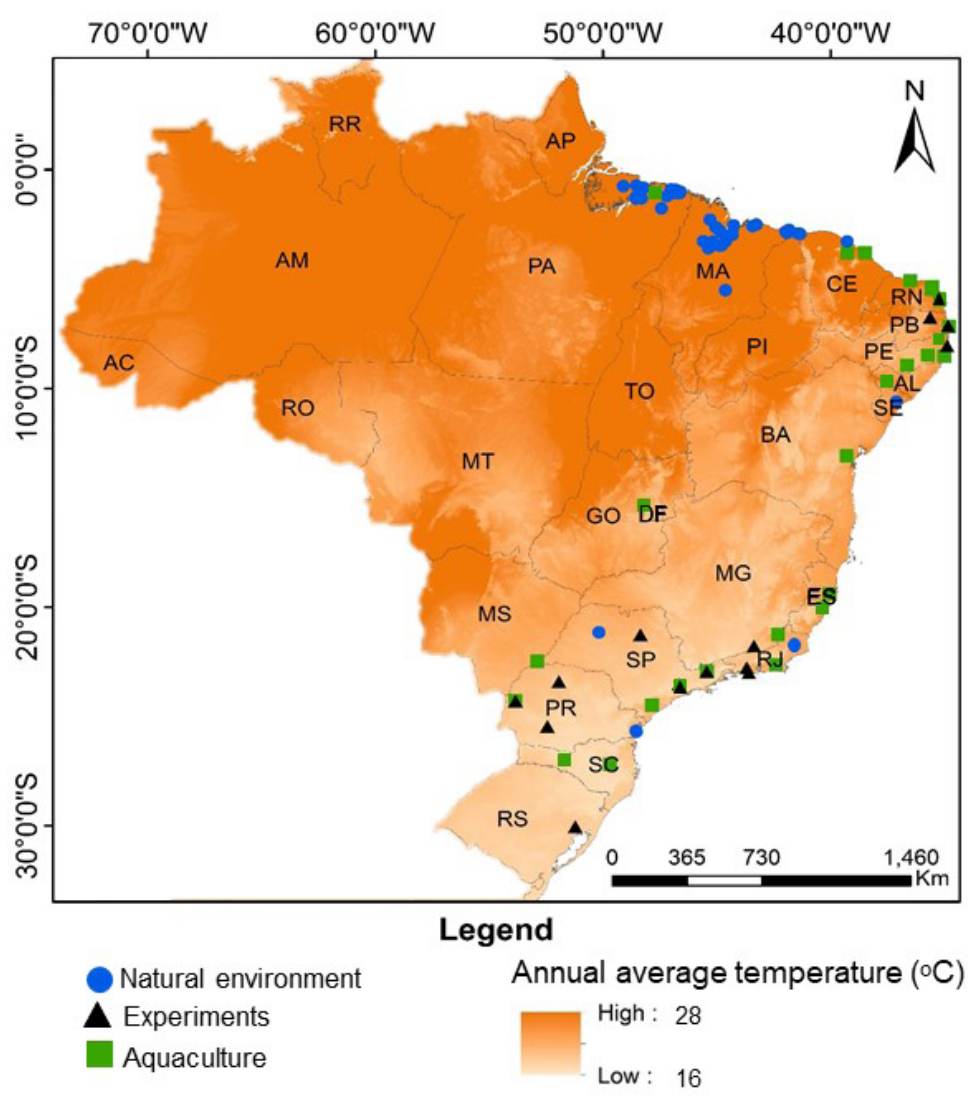
Figure 1. Occurrences of Macrobrachium rosenbergii in Brazil by state and temperature (°C). AC - Acre; AL - Alagoas; AP - Amapá; AM - Amazonas; BA - Bahia; CE - Ceará; DF - Distrito Federal; ES - Espírito Santo; GO - Goiás; MA - Maranhão; MT - Mato Grosso; MS - Mato Grosso do Sul; MG - Minas Gerais; PA - Pará; PB - Paraíba; PR - Paraná; PE - Pernambuco; PI - Piauí; RJ - Rio de Janeiro; RN - Rio Grande do Norte; RS - Rio Grande do Sul; RO - Rondônia; RR - Roraima; SC - Santa Catarina; SP - São Paulo; SE - Sergipe; TO -